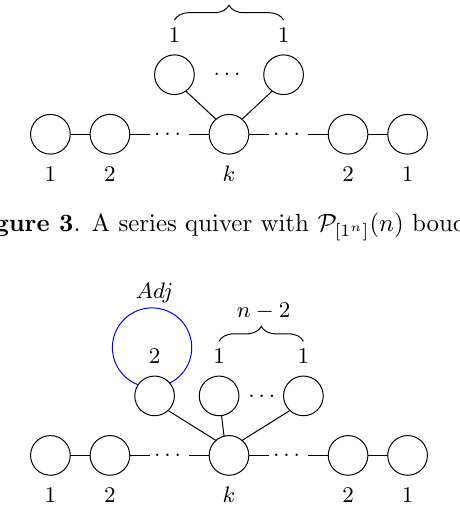
Figure 4 . A-type quiver with P